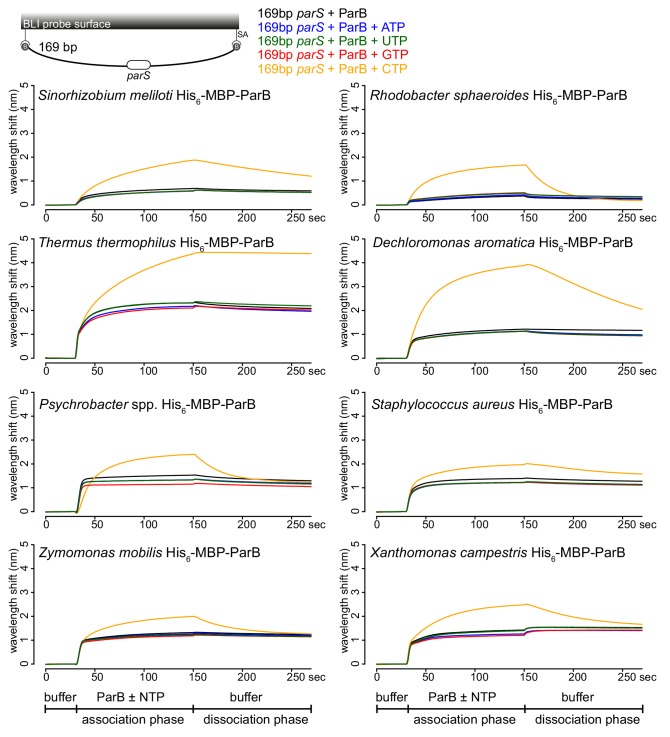
CTP facilitates the association of eight ParB orthologs with DNA.BLI analysis of the interaction between a premix of 1 μM His6-MBP-tagged ParB proteins from a set of diverse bacterial species ± NTPs and a 169 bp dual biotin-labeled parS DNA. NTPs at 1 mM (final concentration) was used, except for BLI experiments with Zymomonas mobilis and Xanthomonas campestris ParBs where 0.01 mM CTP was used instead. Mg2+ was included in all buffers for this experiment. A schematic of the DNA substrate is shown above the sensorgrams.Figure 2—figure supplement 3—source data 1.Data used to generate Figure 2—figure supplement 3.